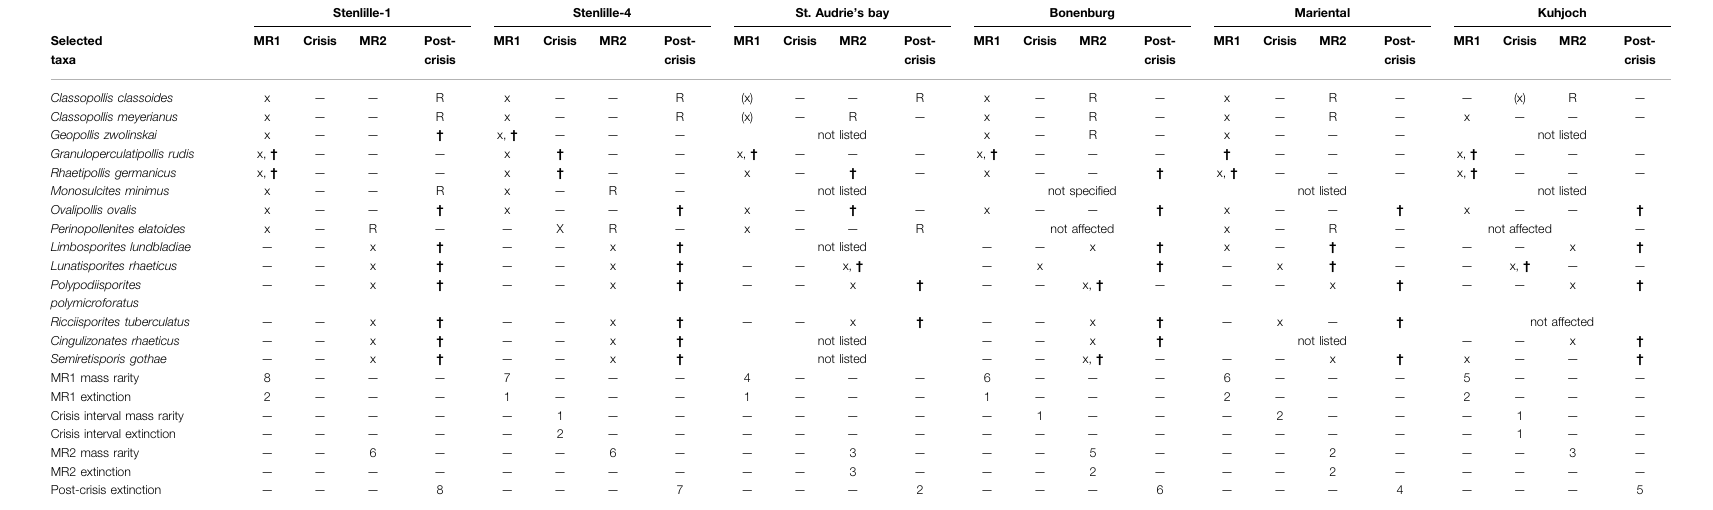
TABLE3| Comparisonofmassrarities,extinctionsandrecoveriesoftheselectedtaxaon Figure1 ,forStenlille-1and-4(thispaper),St.Audrie ’ sBay(UnitedKingdom;Bonisetal.,2010),Bonenburg(Germany;Gravendyck et al., 2020), Mariental (Germany; Heunisch et al., 2010), Kuhjoch (Austria; Bonis et al., 2009; Hillebrandt et al., 2013). The localities are correlated according to ref. 10 10 . In the case of Mariental, only Classopollis spp. is listed. Numbers for the seven lowest lines in the table refer to number of taxa affected during each phase.